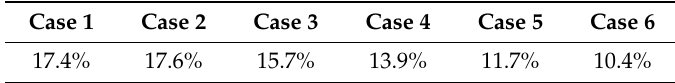
Figure 7. Indicators and SDIs of six cases in group 1. ( a ) Comparison of the significant weighted indicators; ( b ) comparison of the SDI, the on-grid capacity of the DGPVs, and the economic efficiency. Table 11. Integration percentage of DGPVs (on-grid capacity of DGPV/averaged daily load demand) taking into account the investment